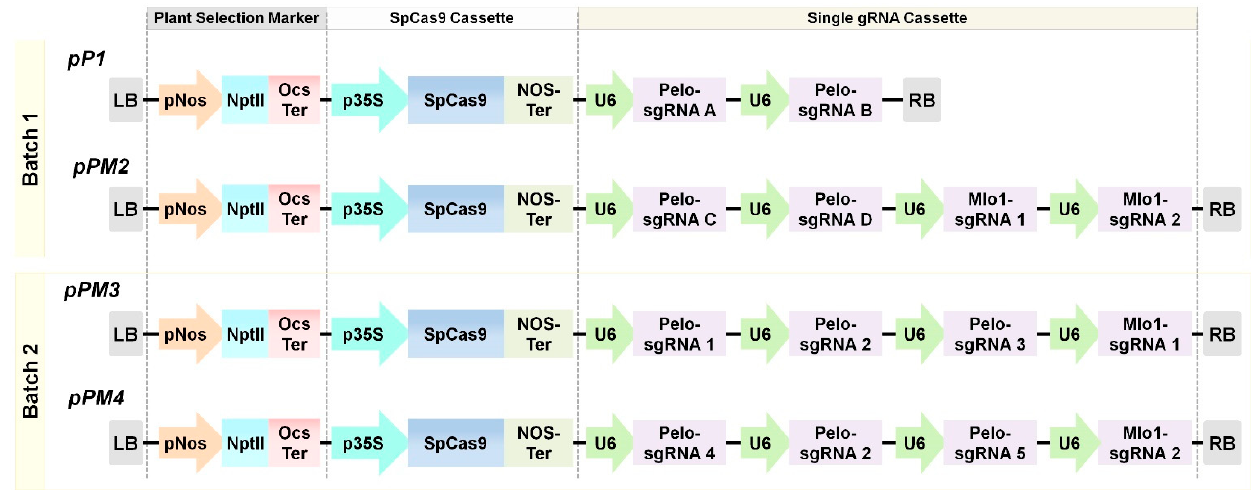
Figure 2. Schematic of the multiplex CRISPR/Cas9 binary transfer-DNA (T-DNA) vector cassettes (pP1, pPM2, pPM3, and pPM4). NPTII, kanamycin resistance gene under pNos promoter and tOcs terminator; p35S, promoter of 35S CaMV (cauliflower mosaic virus); pU6, promoter of AtU6; SpCas9, wild-type Streptococcus pyogenes Cas9; sgRNAs for SlPelo and SlMlo1 ; vector backbone pAGM4723.